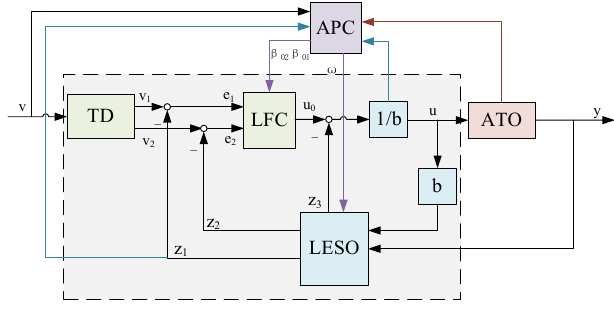
Figure 3. Schematic diagram of the structure of adaptive linear active disturbance rejection